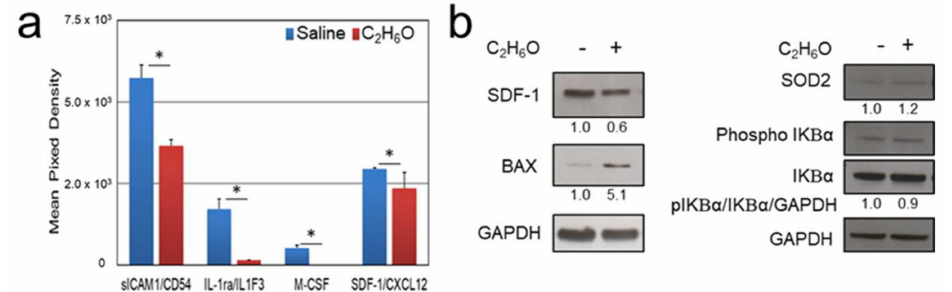
Figure 5. Effects of acute ethanol administration on cytokine/chemokine levels. ( a ) Proteome Profiler Mouse Cytokine Array (R&D Systems) analysis performed on pooled sera from MITO-Luc mice (N = 4 per group) 10 days after administration of either vehicle (saline) or ethanol solution. According to the manufacturer’s instructions, array data were quantified as mean pixel density, normalized to the density of the positive controls. ( b ) Immunoblot analysis performed on tissue homogenates from spleens collected from animals in the groups described above. Glyceraldehyde phosphate dehydrogenase (GAPDH) was used as a protein loading control. Band intensities were quantified using the ImageJ software and numbers indicate the normalized ratio of the indicated proteins to relative GAPDH